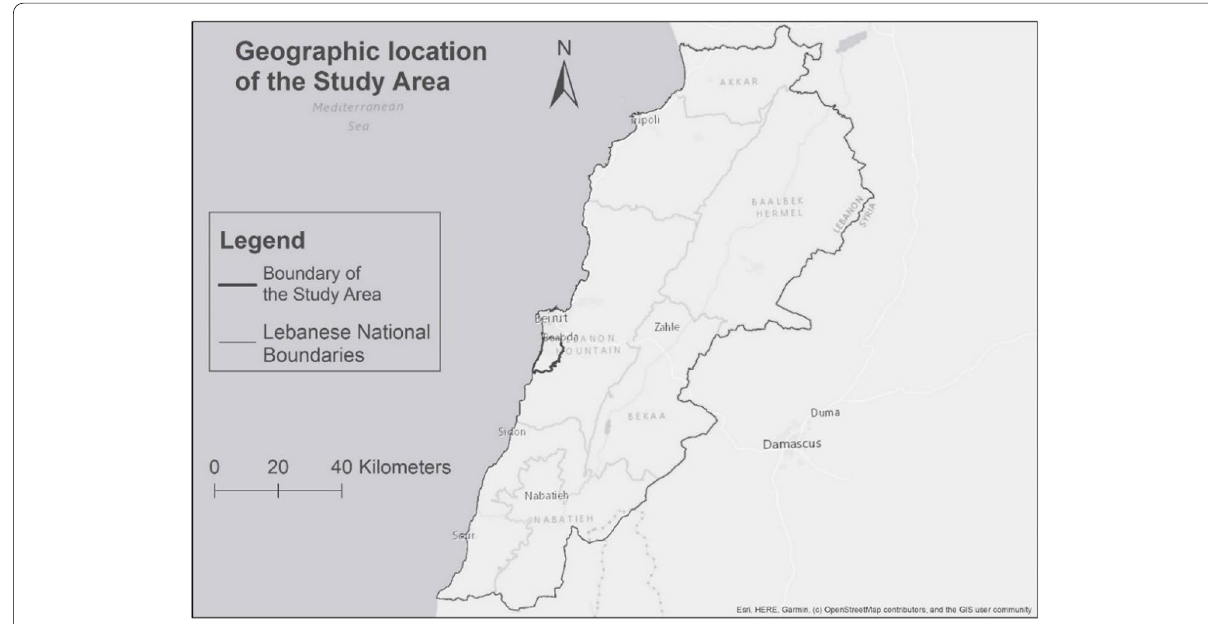
Fig. 1 The location of the study area relatively to